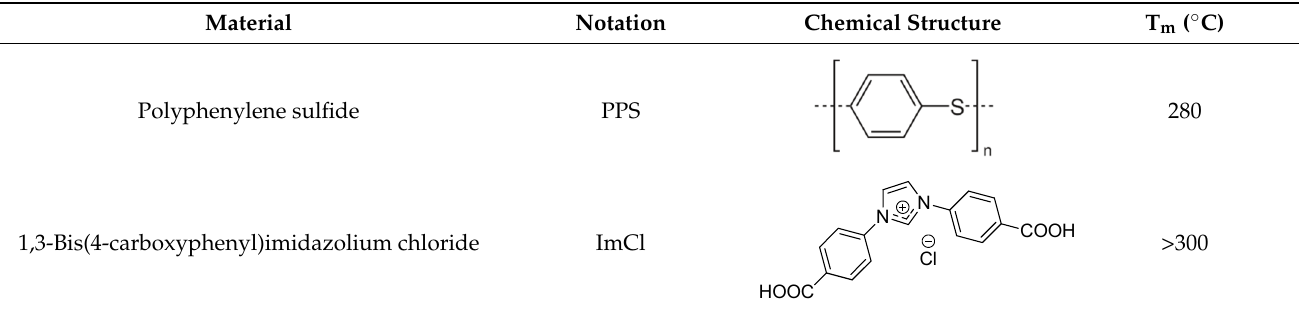
Table 1. Chemical structure of PPS polymer and ionic